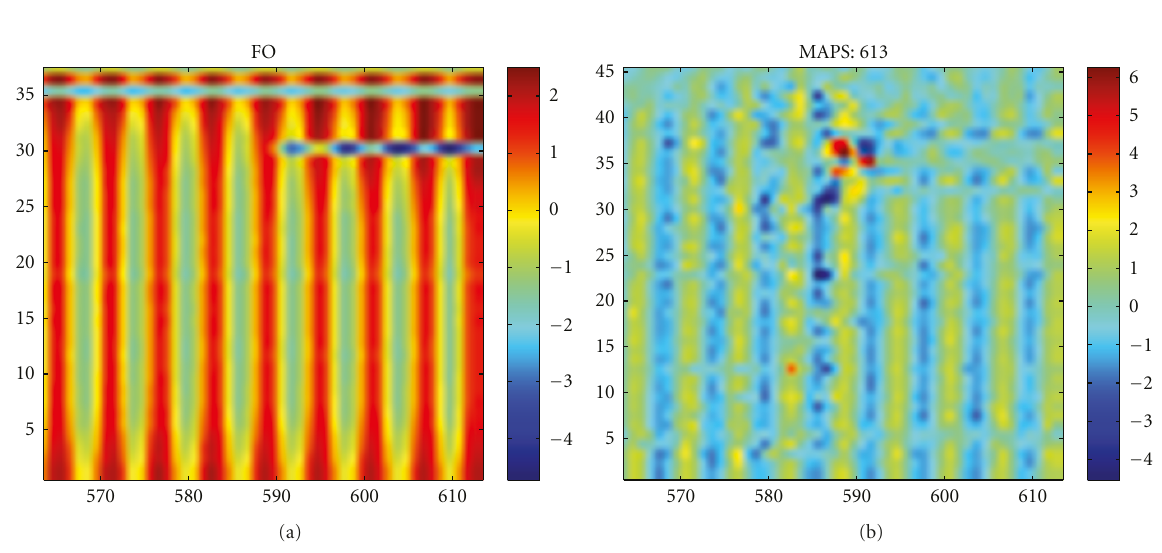
Figure 12: Wire 35 break.